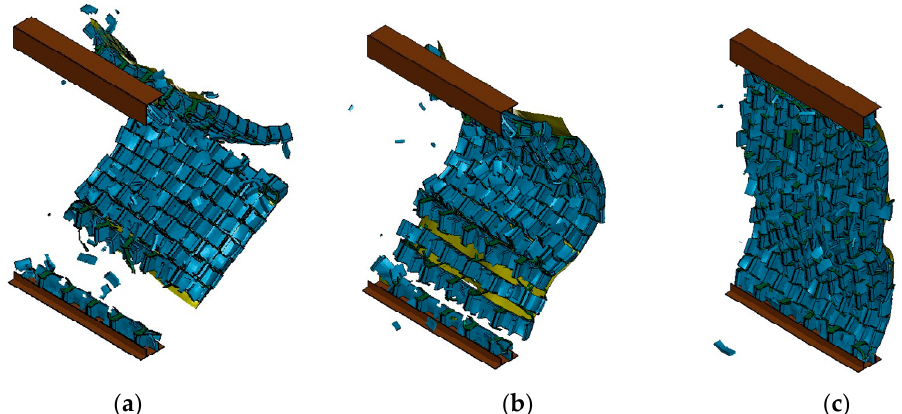
Figure 15. Influence of SPUA layer thickness to damage pattern: ( a ) 3.175 mm; ( b ) 6.35 mm; ( c ) 12.7 mm.